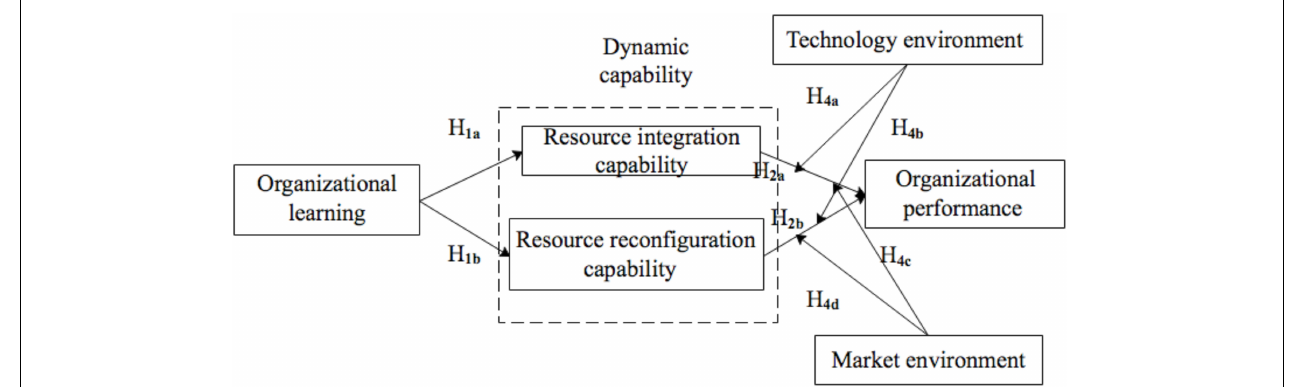
FIGURE 1 | Research